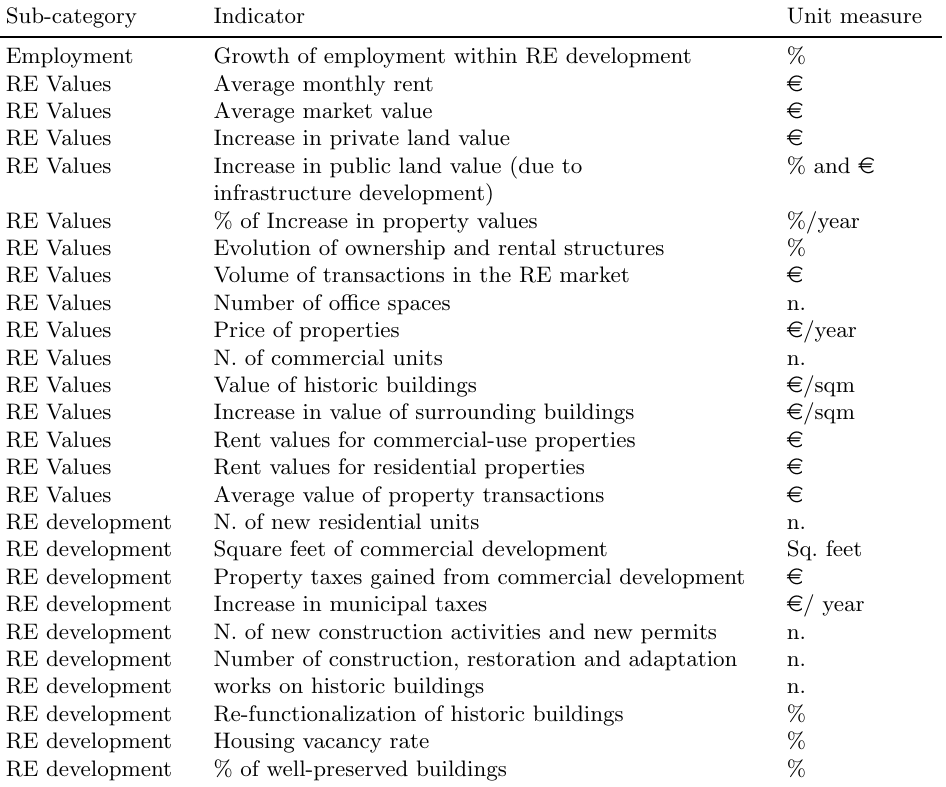
Table 4: Real estate (RE) economic indicators